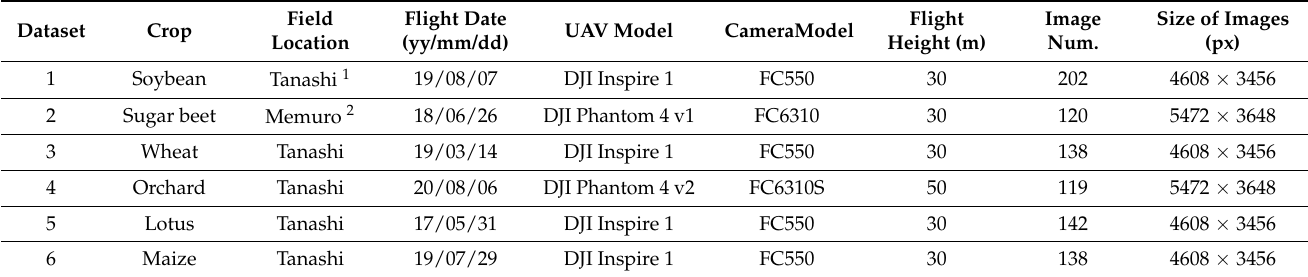
Table 1. Trial field and image acquisition